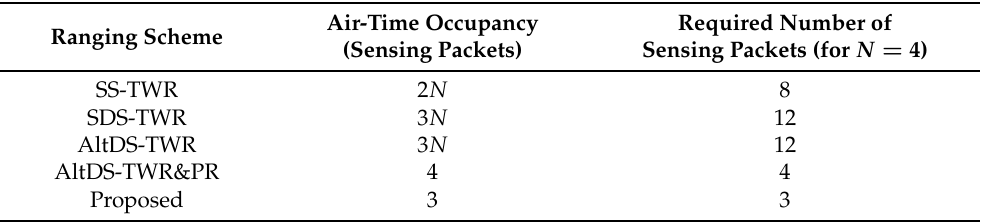
Table 1. Comparison of the proposed ranging scheme’s air-time occupancy for N passive anchor nodes in a UWB network.